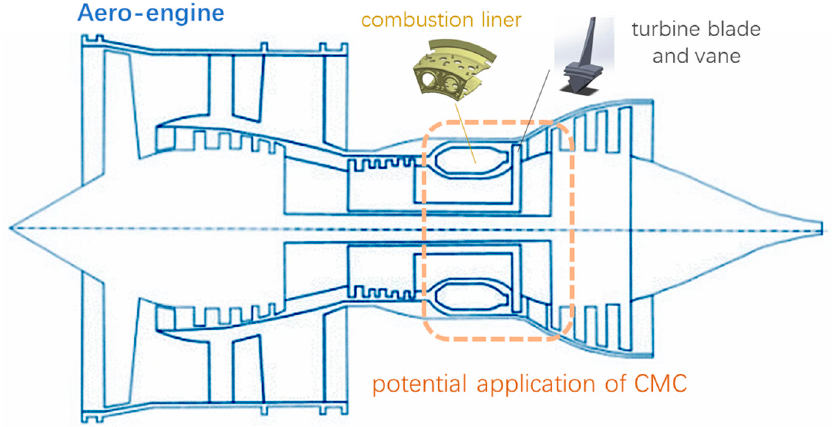
Figure 1. Potential application of CMC components in aero-engines.